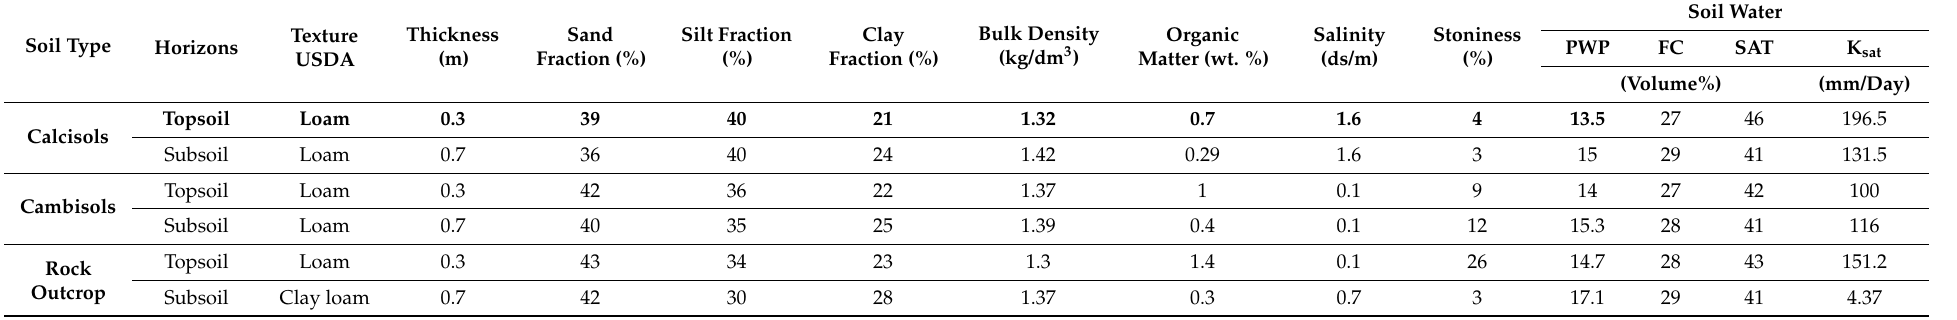
Table 1. Soil characteristics of Peshawar Basin, Pakistan. PWP stands for permanent wilting point, FC for field capacity, SAT for saturation, and K sat for saturated hydraulic conductivity.